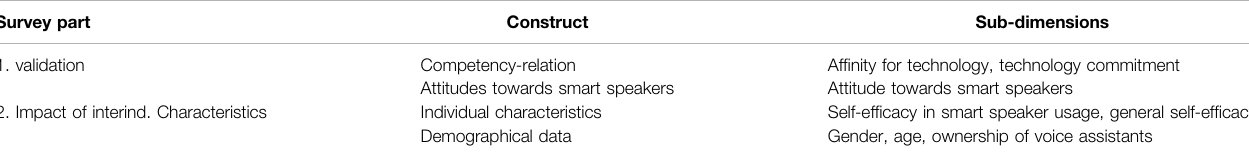
TABLE 6 | The survey structure of PART II. Survey part